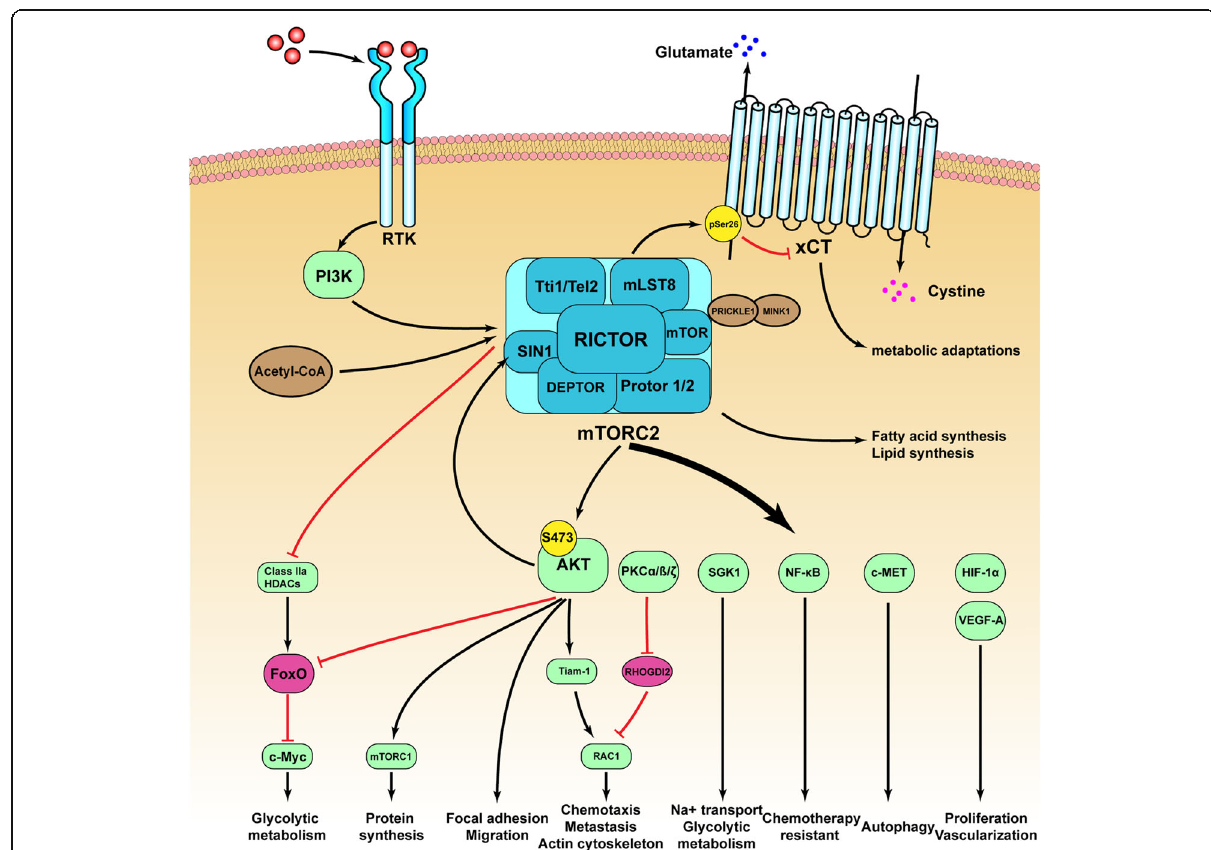
Fig. 1 The mechanisms by which RICTOR participating in tumor growth, invasion and drug